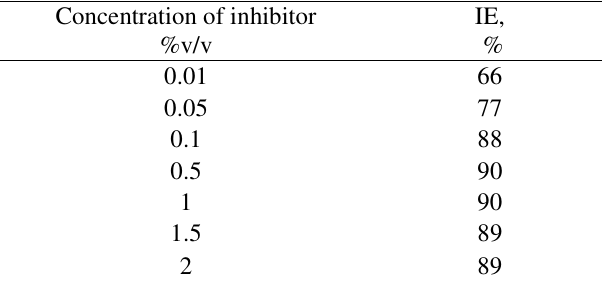
SO (Weight loss 2 4